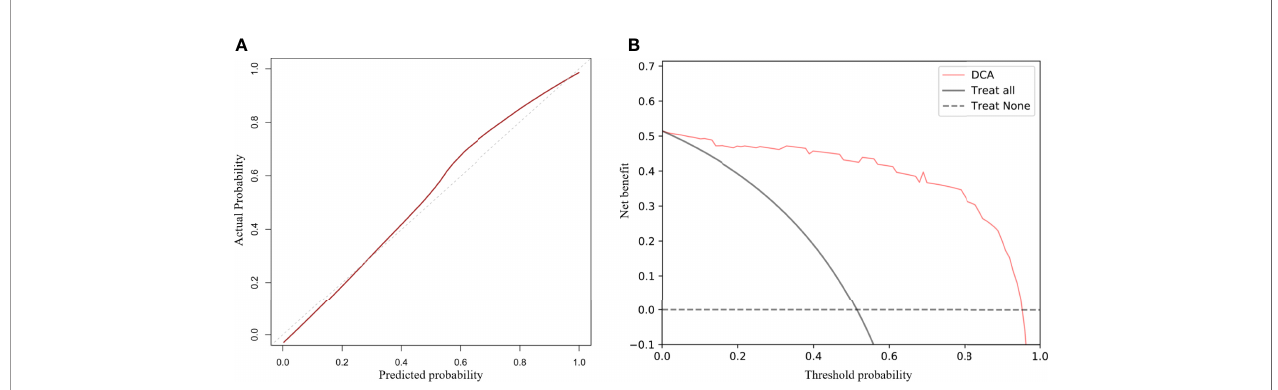
FIGURE 4 | Calibration curves and decision curve analysis (DCA) of the nomogram. Calibration curves for the radiomics nomogram (A) . The Y-axis represents actual outcome of response to neoadjuvant chemotherapy, and the X-axis represents the predicted probability. The closer the fi t of the diagonal red line to the ideal dotted line indicates the predictive accuracy of the nomogram. DCA for the radiomics nomogram (B) . The Y-axis represents the net bene fi t. The X-axis represents the threshold probability. The net bene fi t of the nomogram is greater than that of the all or none scheme at a wide range of threshold